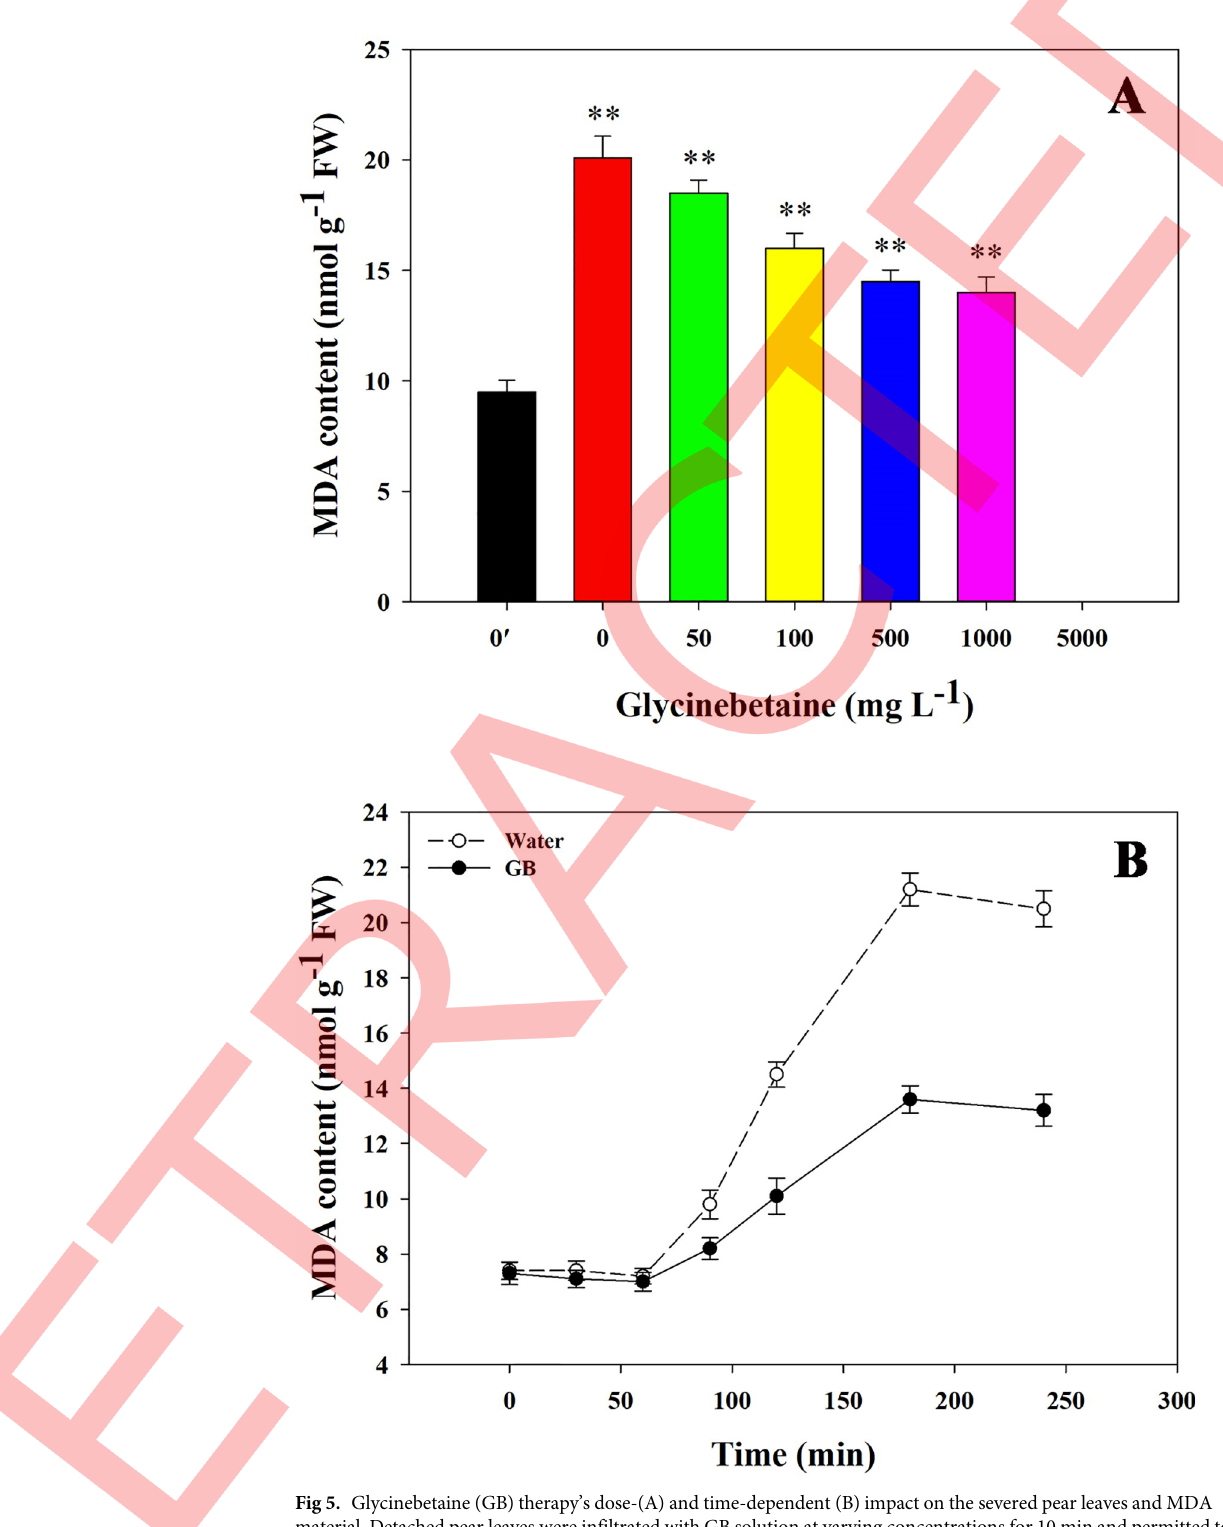
Fig 5. Glycinebetaine (GB) therapy’s dose-(A) and time-dependent (B) impact on the severed pear leaves and MDA material. Detached pear leaves were infiltrated with GB solution at varying concentrations for 10 min and permitted to lose water in natural fresh weight (A) or for a separate period (B) through up to 15% evaporation. MDA content was calculated as defined in the Materials and methods section. A was used as a control for nondehydrated leaves that had not been treated with GB (0’). Substantial variations in regulation (0’) were observed ( �� P < 0.01, Student 0 s t -test). Three replicates are shown as means ± SD. https://doi.org/10.1371/journal.pone.0251389.g005 PLOS ONE | https://doi.org/10.1371/journal.pone.0251389 November18,